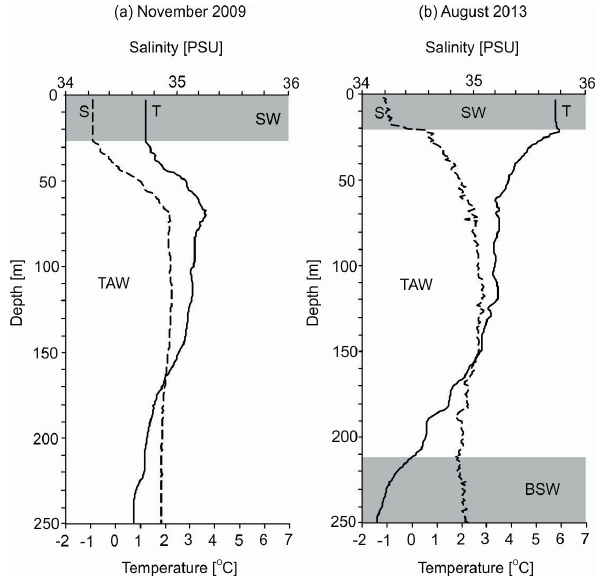
Figure 2. Temperature and salinity versus depth, measured on 5 November 2009 (a) and on 13 August 2013 (b) at the site of core JM09-020GC. SW: Surface Water, TAW: Transformed Atlantic Wa- ter, BSW: Brine-enriched Shelf